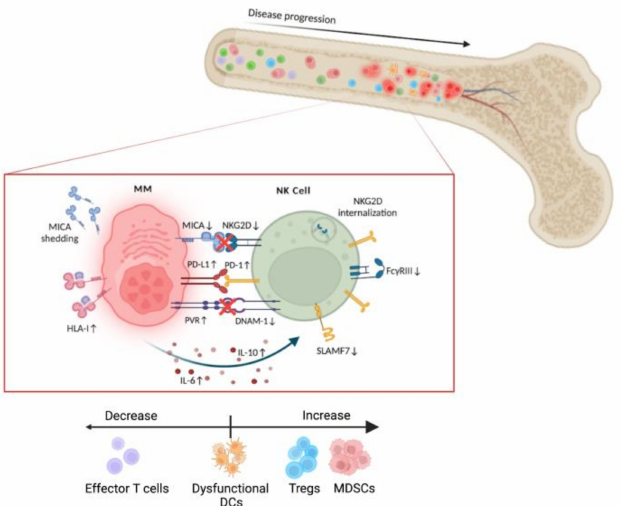
Figure 1. Schematic representation of the immunosuppressive MM microenvironment and the deleterious effect on NK cell anti-myeloma function. Created with